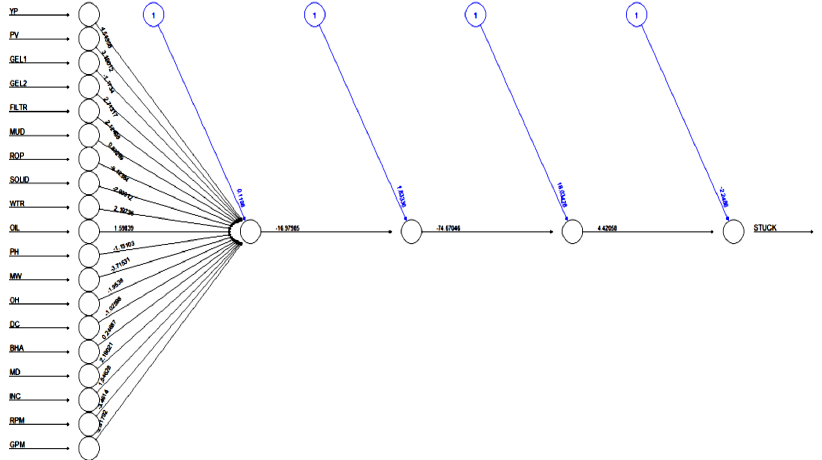
Figure 1. Neural network topology [19, 1, 1, 1, 1].